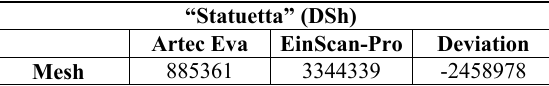
Table 8. DSh analysis of the “Statuetta” model